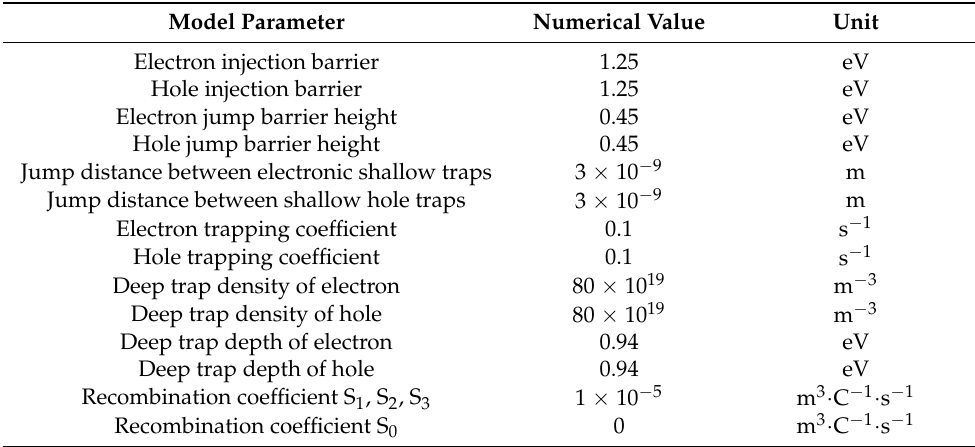
Deep trap density of hole Deep trap depth of hole Recombination coefficient S 1 , S 2 , S